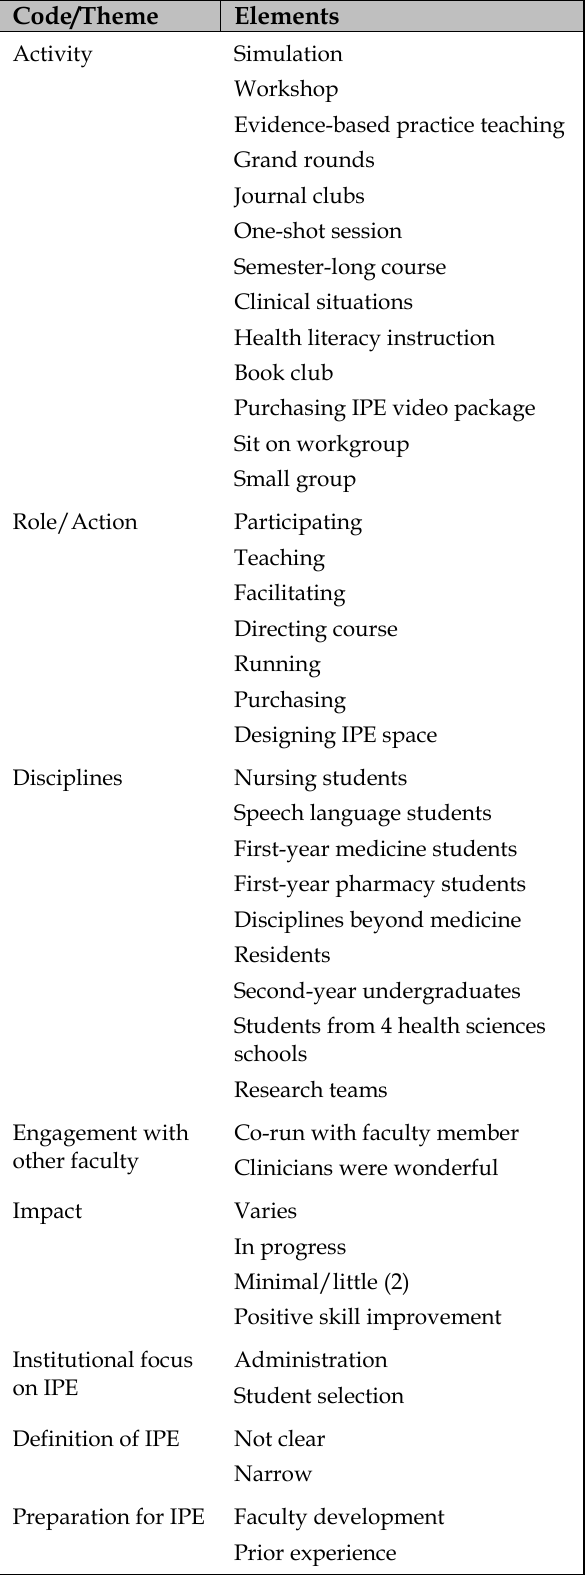
Table 4 Code listing for qualitative analysis